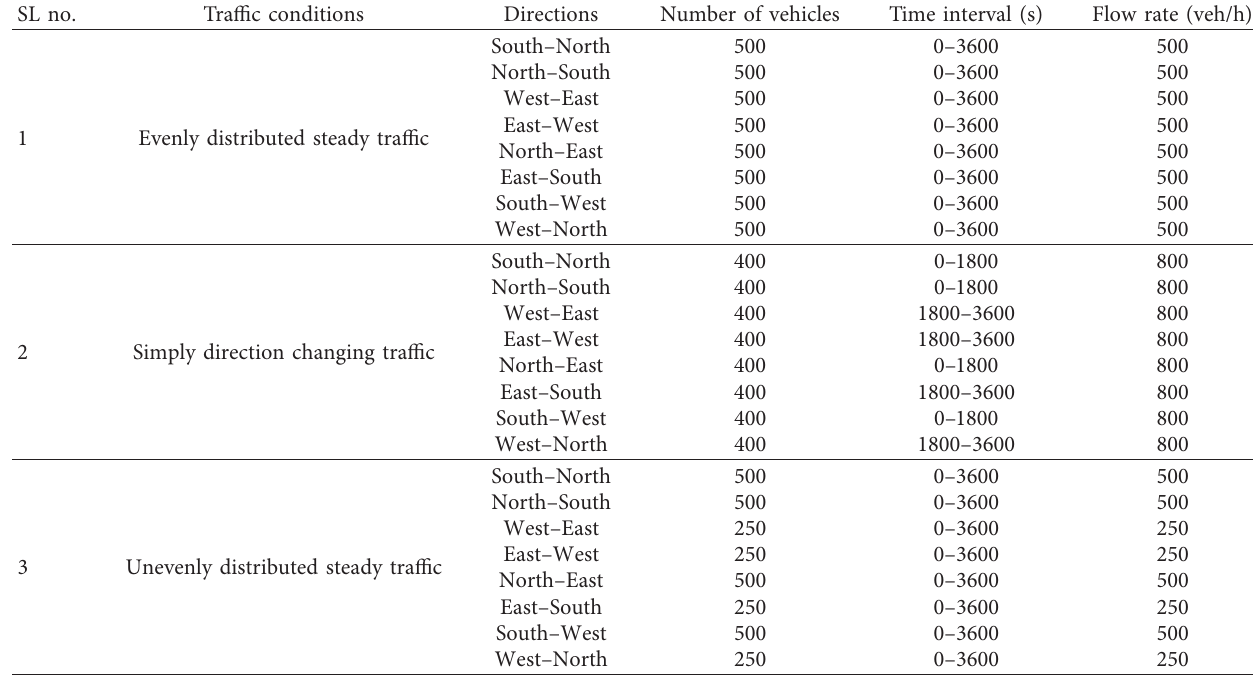
Table 2: Configurations of simulation data in single-intersection case.